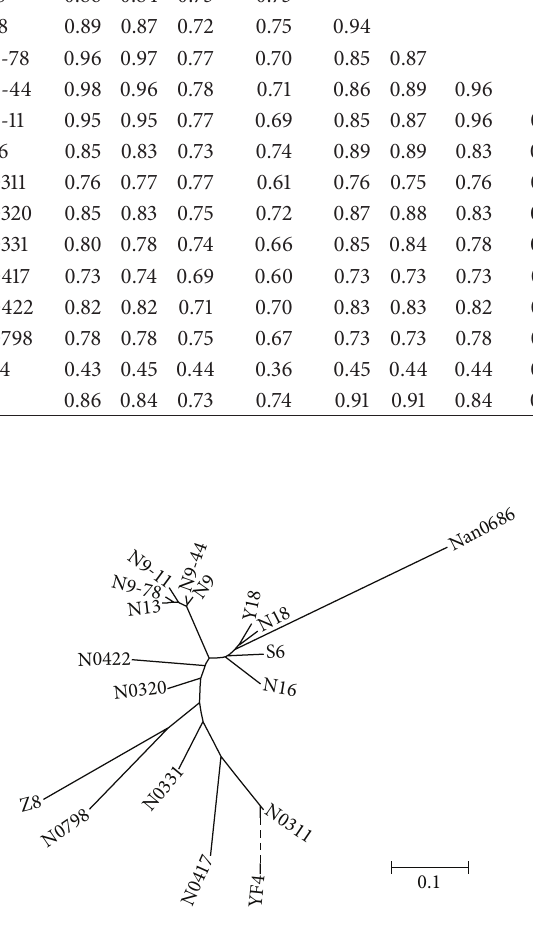
Figure 1: Dendrogram of Ningmai 9 and its derivatives based on Neighbor-Joining analysis. The genetic distance of Yangfumai 4 was very large and broken down with dashed